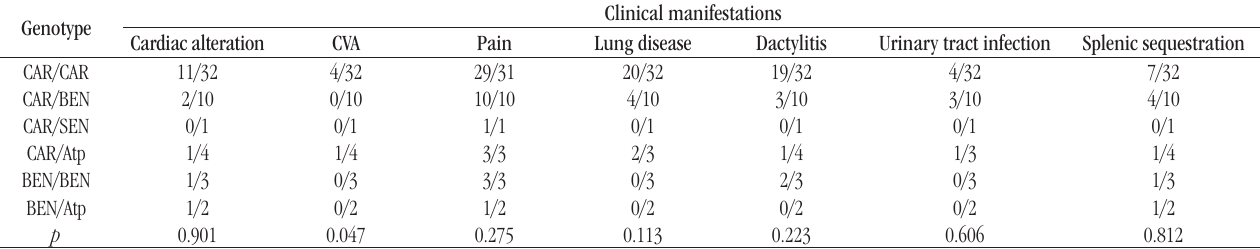
taBLE 3 − Sickle cell genotypes and clinical